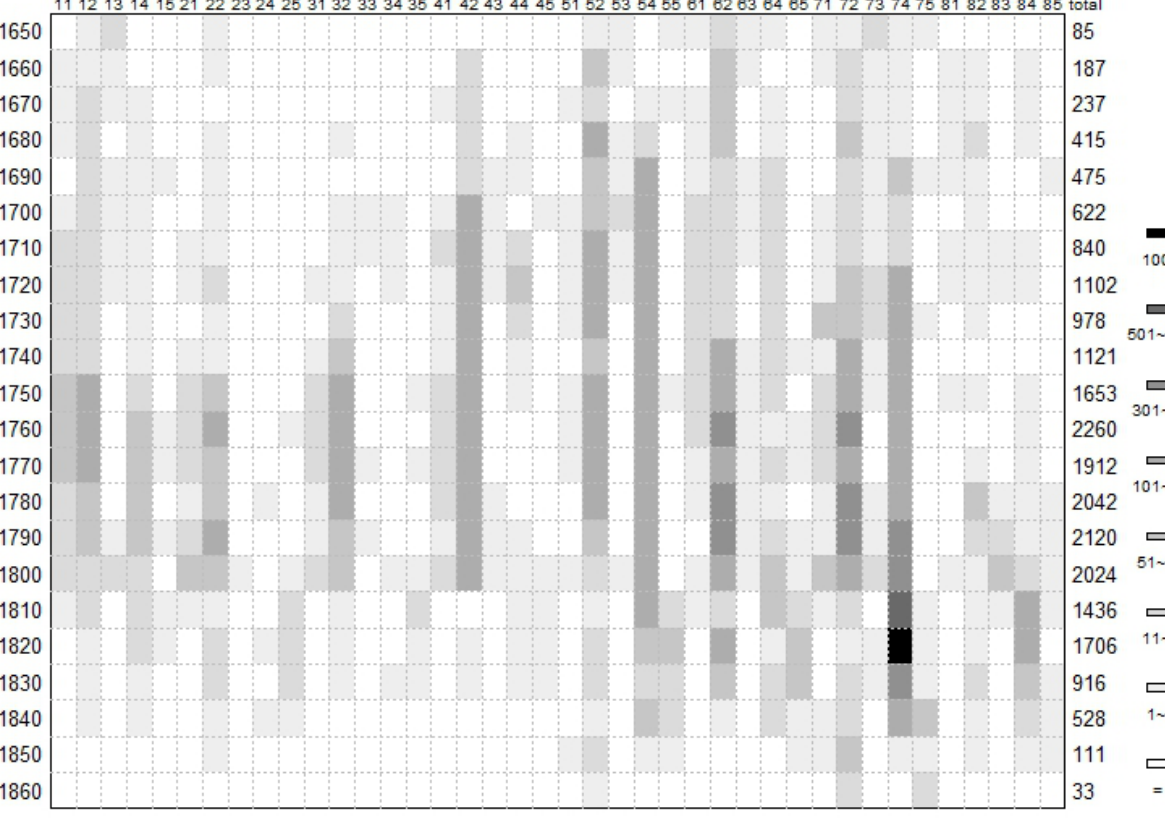
Figure 4. Number of Voyages per Decade, by Route (for Fully Documented Routes). {Data1, “Documented routes,” 22,803